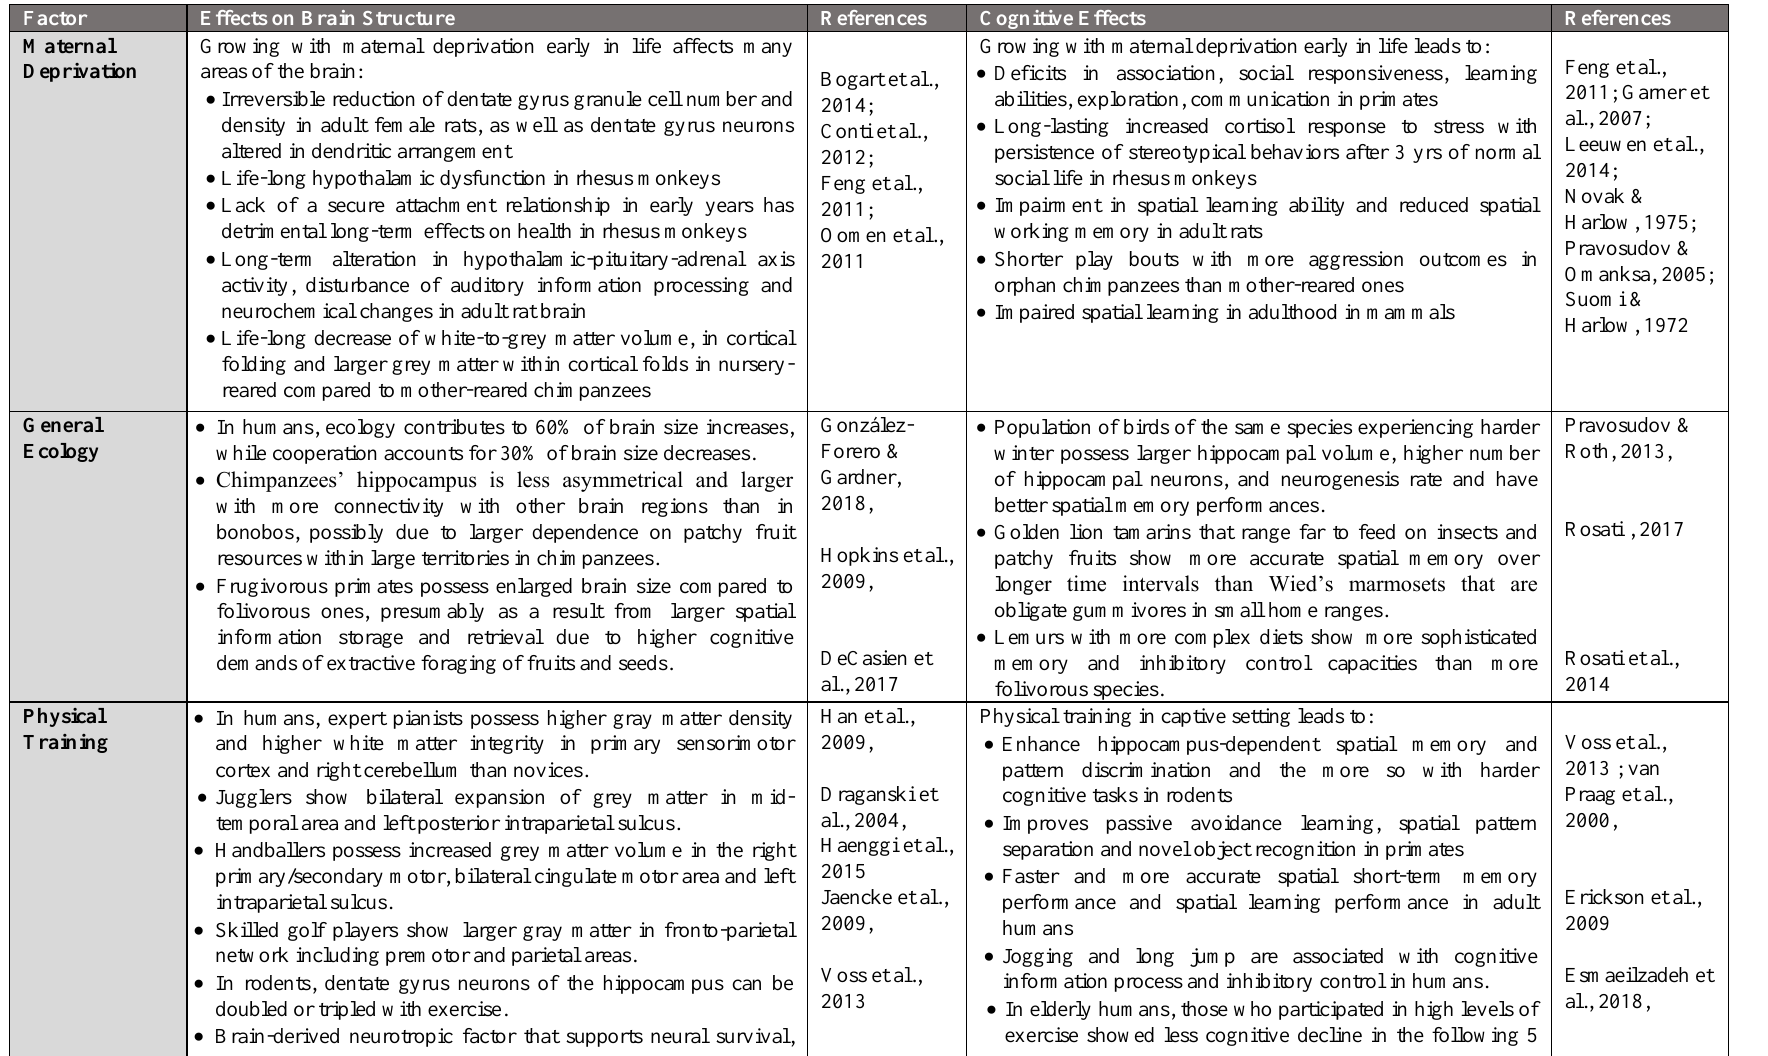
Summary of Some of the Data Showing the Different Effects of the Socio-Ecological Environment on the Development of Brain Structures and Cognition Factor Effects on Brain